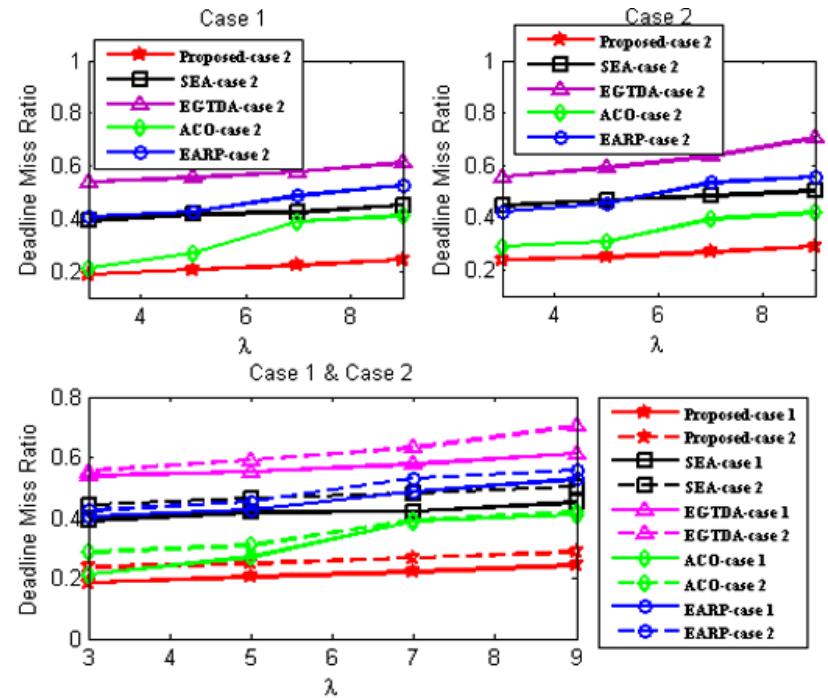
Figure 11. Influence of increasing average traffic rate on deadline miss ratio under the second sce-